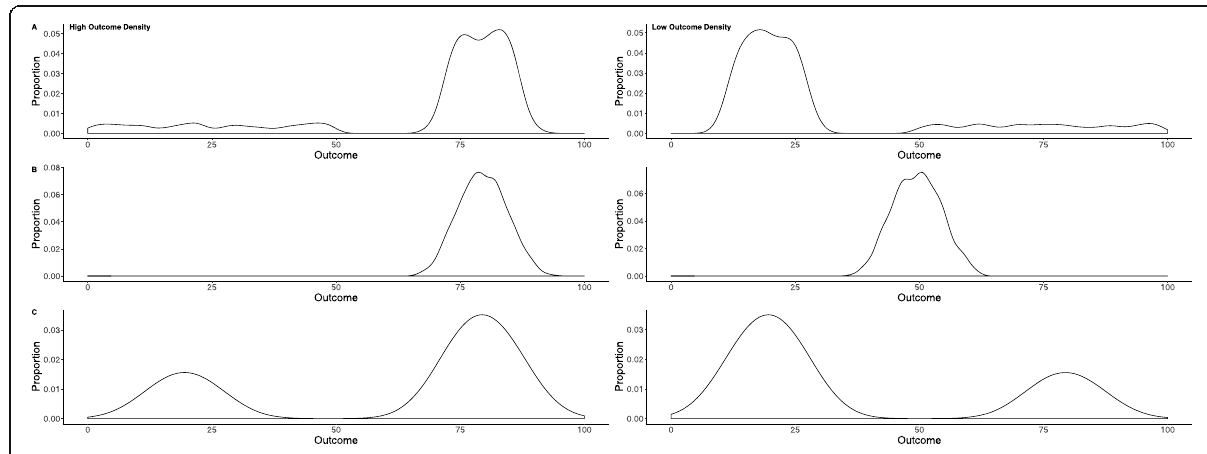
Fig. 5 Example outcome distributions used in a Experiment 2, b Experiments 3, 5, and 6 and c Experiment 4. Distributions for the high outcome density condition are the left panels, while distributions for the low outcome density condition are the right panels